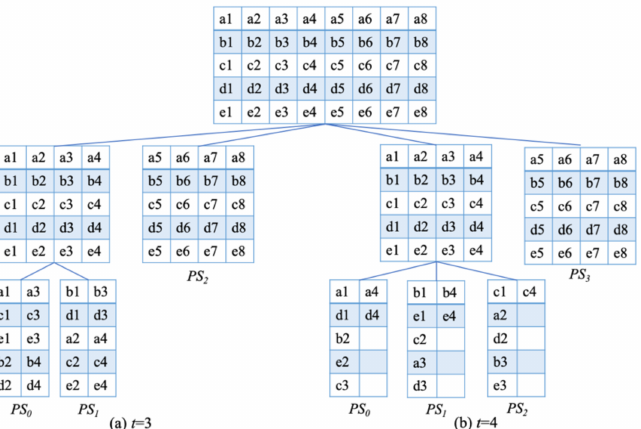
Figure 2. Example of sharing 5 pixels by the proposed secret image partition strategy ( SIPS ), ( a ) shares to 3 groups of PS 0 , PS 1 , PS 2 , ( b ) shares to 4 groups of PS 0 , PS 1 , PS 2 , PS 3